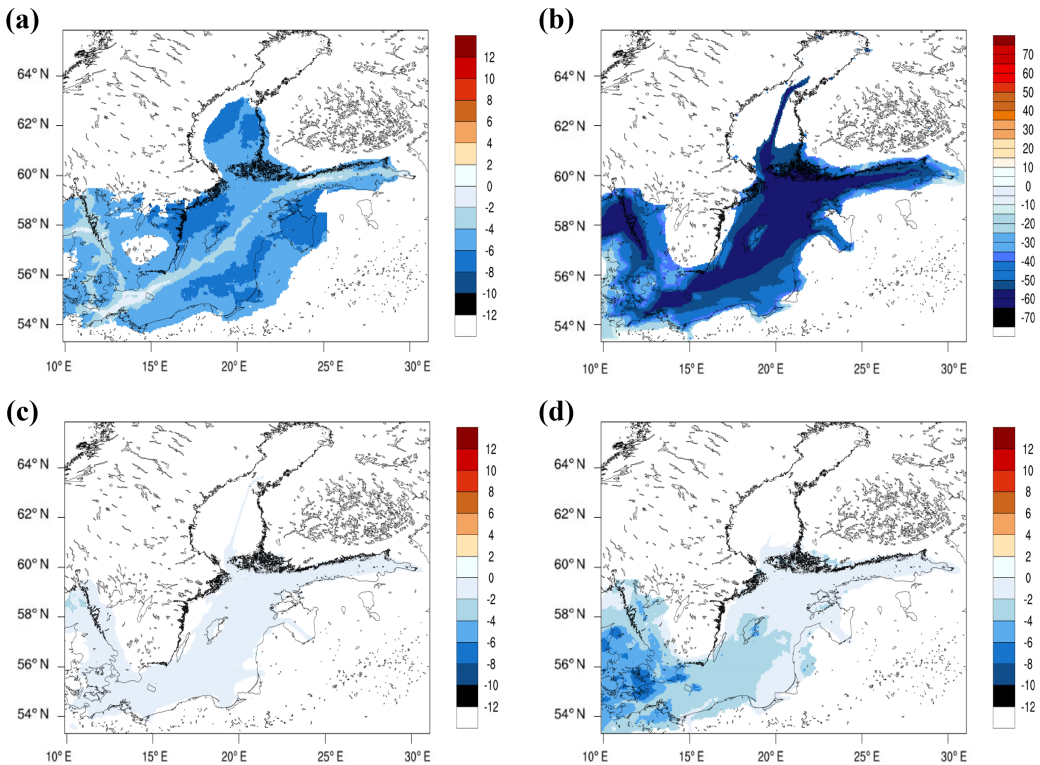
Figure 9. Effect of establishing the NECA (in 2021) on the future air quality in summer (JJA) 2040 in the Baltic Sea region as relative difference (in percent) between the scenario simulations BAU 2040 and NoNECA 2040: (a) daily maximum O 3 , (b) NO 2 , (c) SO 2 and (d) PM 2 . 5 . Not coloured (white) areas indicate grid cells with ship contribution in BAU 2040 of less than 1.0ppbv, 0.1ppbv, 0.01ppbv and 0.005µgm − 3 , for daily max O 3 , NO 2 , SO 2 and PM 2 . 5 ,